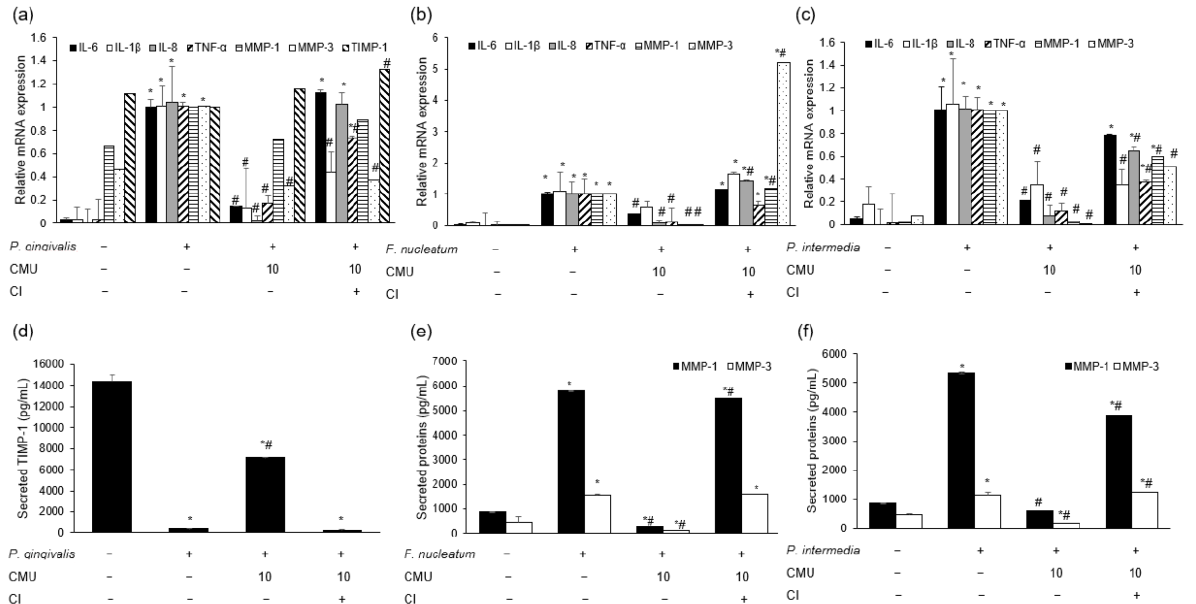
Figure 9. Effects of blocking direct contact between W. cibaria CMU and HGFs cells on the gene ( a – c ) and protein expression ( d – f ) of inflammatory mediators induced by P. gingivalis ( a , d ), F. nuclea- tum ( b , e ), and P. intermedia ( c , f ). W. cibaria CMU was pre-treated for 30 min at 10-fold the dose of P. gingivalis , F. nucleatum , or P. intermedia and then incubated with each periodontopathogen (MOI = 100) for 4 h ( a – c ) or 24 h ( d – f ). CMU, W. cibaria CMU; CI, cell culture inserts in the Transwell system. Data are presented as the mean ± standard deviation. * p < 0.05, compared to the untreated group. # p < 0.05, compared to the control